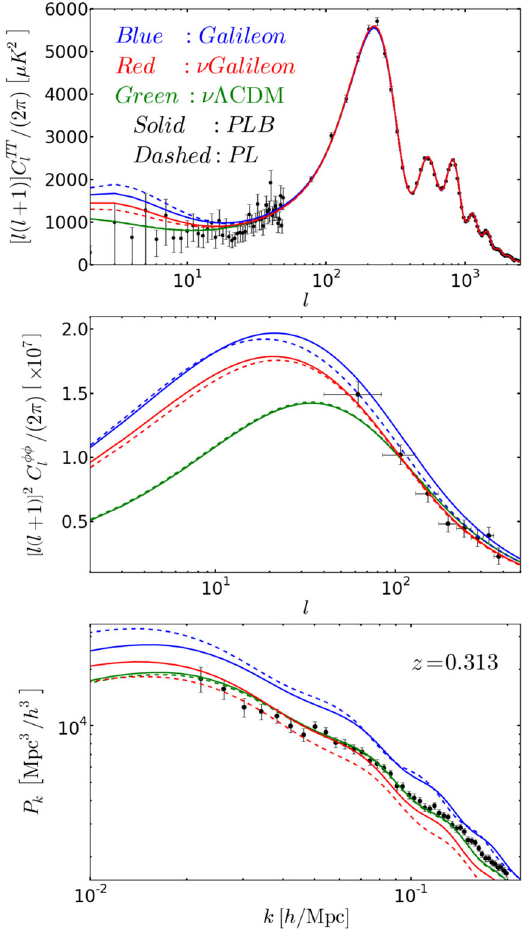
Fig. 4 These plots illustrate the differences between Λ CDM and Galileon models (see Sect. 7.3.1), with and without massive neutrinos. The Galileon models have background Friedmann equations that contain a scalar-field energy density contribution that generates late time cosmic acceleration and has an evolution consistent with observations and thus similar to that of a Λ CDM model. The Galileon scalar field here also affects linear perturbations and is not coupled to matter. The effect of the Galileon field considered here is focused on large-scale structure. The Top: CMB temperature power spectra showing the ISW effect at low multipoles. Middle: CMB lensing potential spectra. Bottom: linear matter power spectra. The models plotted in dashed lines indicate their best fit models to Ade et al. (2014c) temperature data, WMAP9 polarization data (Hinshaw et al. 2013), and Planck-2013 CMB lensing (Ade et al. 2014d). They note these as PL models. The solid lines indicate their best fits to CMB data (i.e., PL) plus BAO measurements from 6dF, SDSS DR7 and BOSS DR9. They note these as PLB models. The models correspond to best-fitting base Galileon modified gravity model (in blue), ν Galileon (in red) and νΛ CDM (in green). For the last two models, the authors added massive neutrino. In the upper and middle panels, the data points show the power spectrum measured by the Planck satellite (Ade et al. 2014c). In the lower panel, the data points show the SDSS-DR7 Luminous Red Galaxy power spectrum of Reid et al. (2010), but scaled down to match the amplitude of the best-fitting ν Galileon (PLB) model (Barreira et al. 2014a). We refer to this figure from various parts of the text. Image reproduced with permission from Barreira et al. (2014a), copyright by